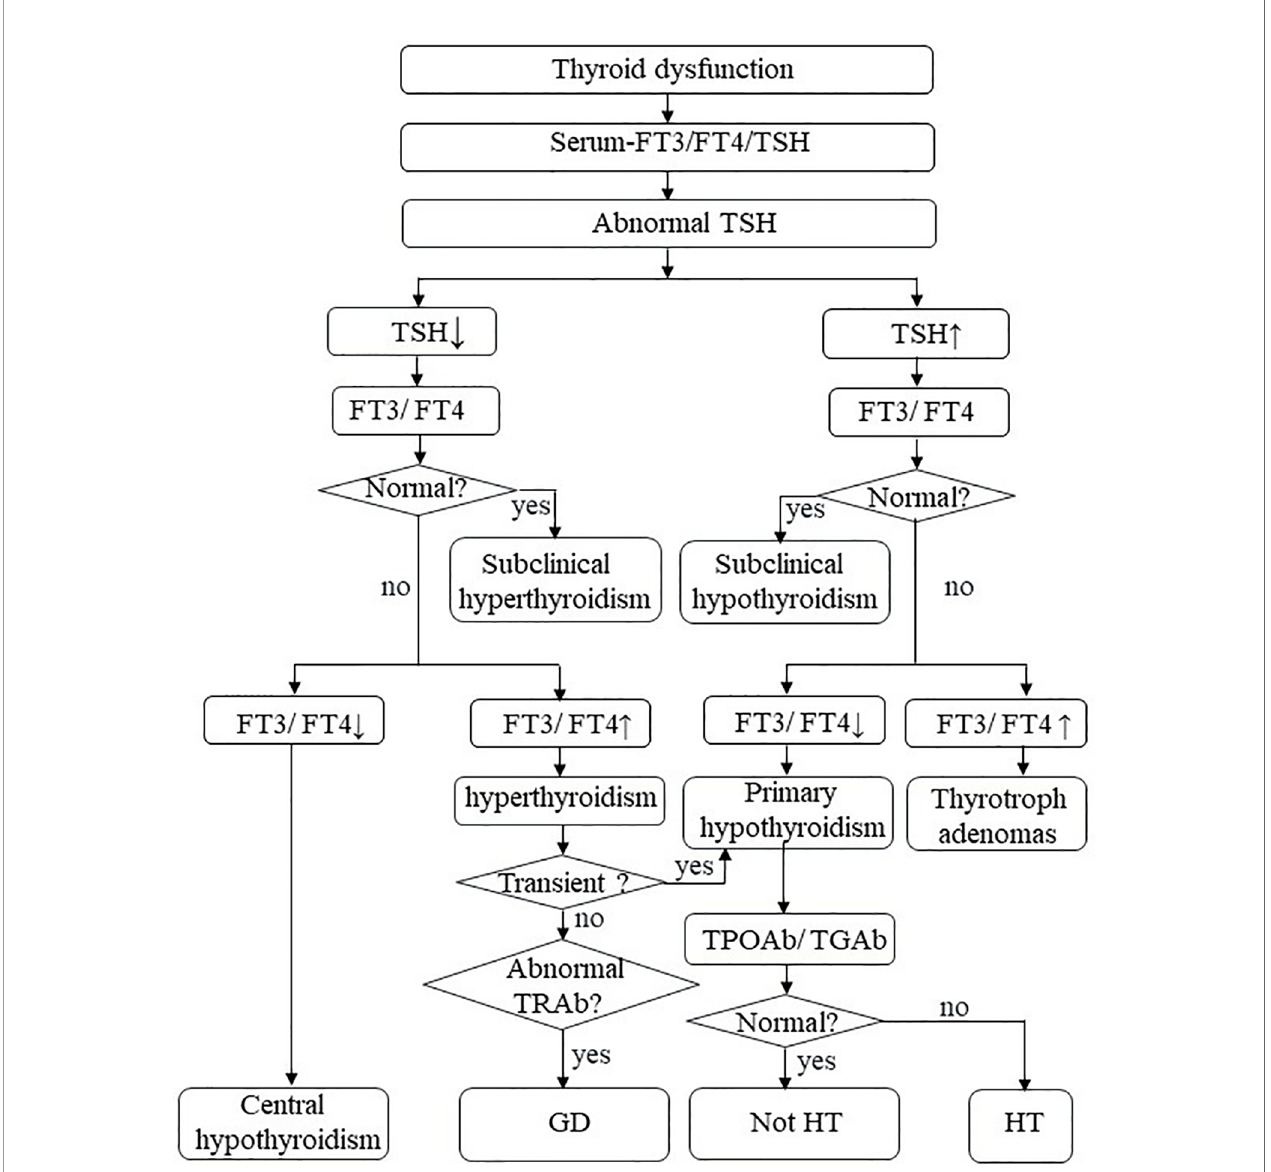
FIGURE 1 | Thyroid dysfunction. FT3, free triiodothyronine; FT4, free thyroxine; TSH, thyroid-stimulating hormone; TPO-Ab, thyroperoxidase antibodies; TG-Ab, thyroglobulin antibody; TRAb, TSH receptor antibodies; HT, Hashimoto ’ s thyroiditis; GD, Graves ’